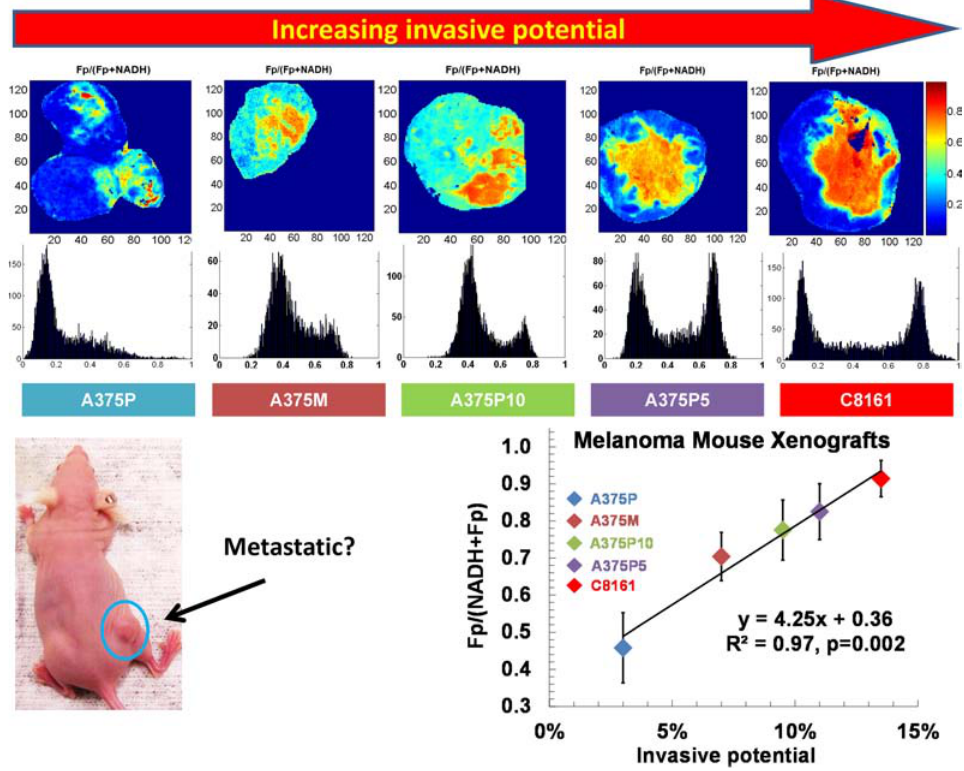
Fig. 2. The typical Fp redox ratio images and their corresponding histograms of the ¯ve melanoma lines (A375P, A375M, A375P10, A375P5, and C8161) and the positive linear correlation between the Fp redox ratio and tumor invasive potential. The Fp redox ratios in the redox core (the right peaks in the histograms) were plotted against the invasive potentials of the ¯ve cell lines measured by the Boyden chamber method. The ¯gure is reproduced with permission from Ref.